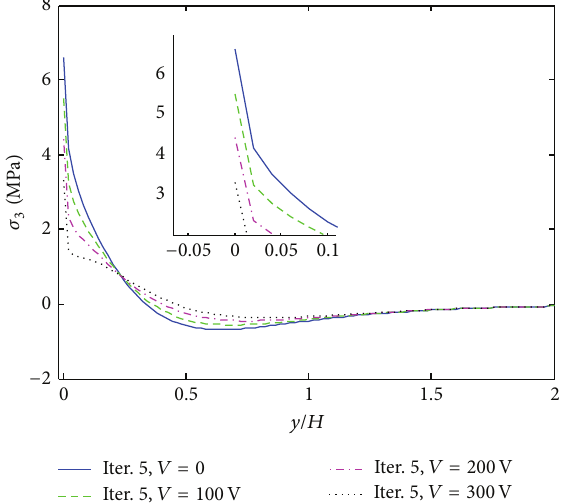
Figure 7: 𝜎 3 distribution of [PZT/0 4 /90 4 ]s laminate at the interface of 𝑧/𝐻 = 1/6 , under 0.1% uniaxial strain.